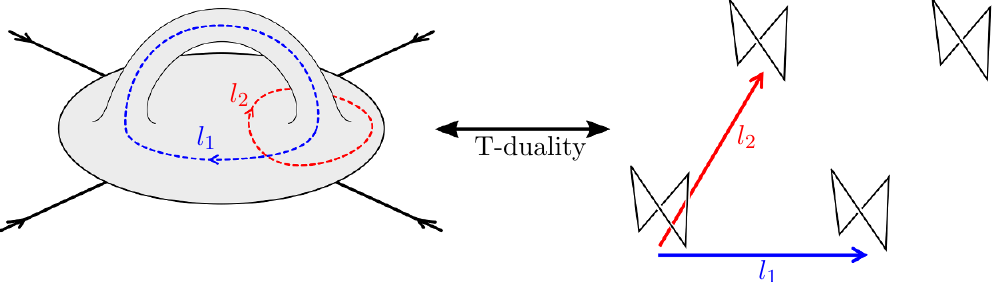
Figure 17 . An extension of the double trace duality to a duality between the 1 =N 2 correction to the single trace partial amplitude (on the left) and a periodic correlation function of a Wilson loop-like object (on the right). In this case there are two cuts (cid:13) 1 and (cid:13) 2 with momenta l 1 and l 2 , that correspond to the two cycles of the torus. They are non-self intersecting cuts of the Feynman diagrams that have intersection number one with each other. The generalization of the cylinder cut (2.5) now take the form A ( l 1 ; l 2 ) = P A (cid:13) 1 (cid:13) 2 ( g: ( l 1 ; l 2 ) T ). On the Wilson loop side one g 2 SL(2 ; Z ) (cid:12)nds a lattice of closed polygonal Wilson loops, which is the universal cover of the torus and has two periods, l 1 and l 2